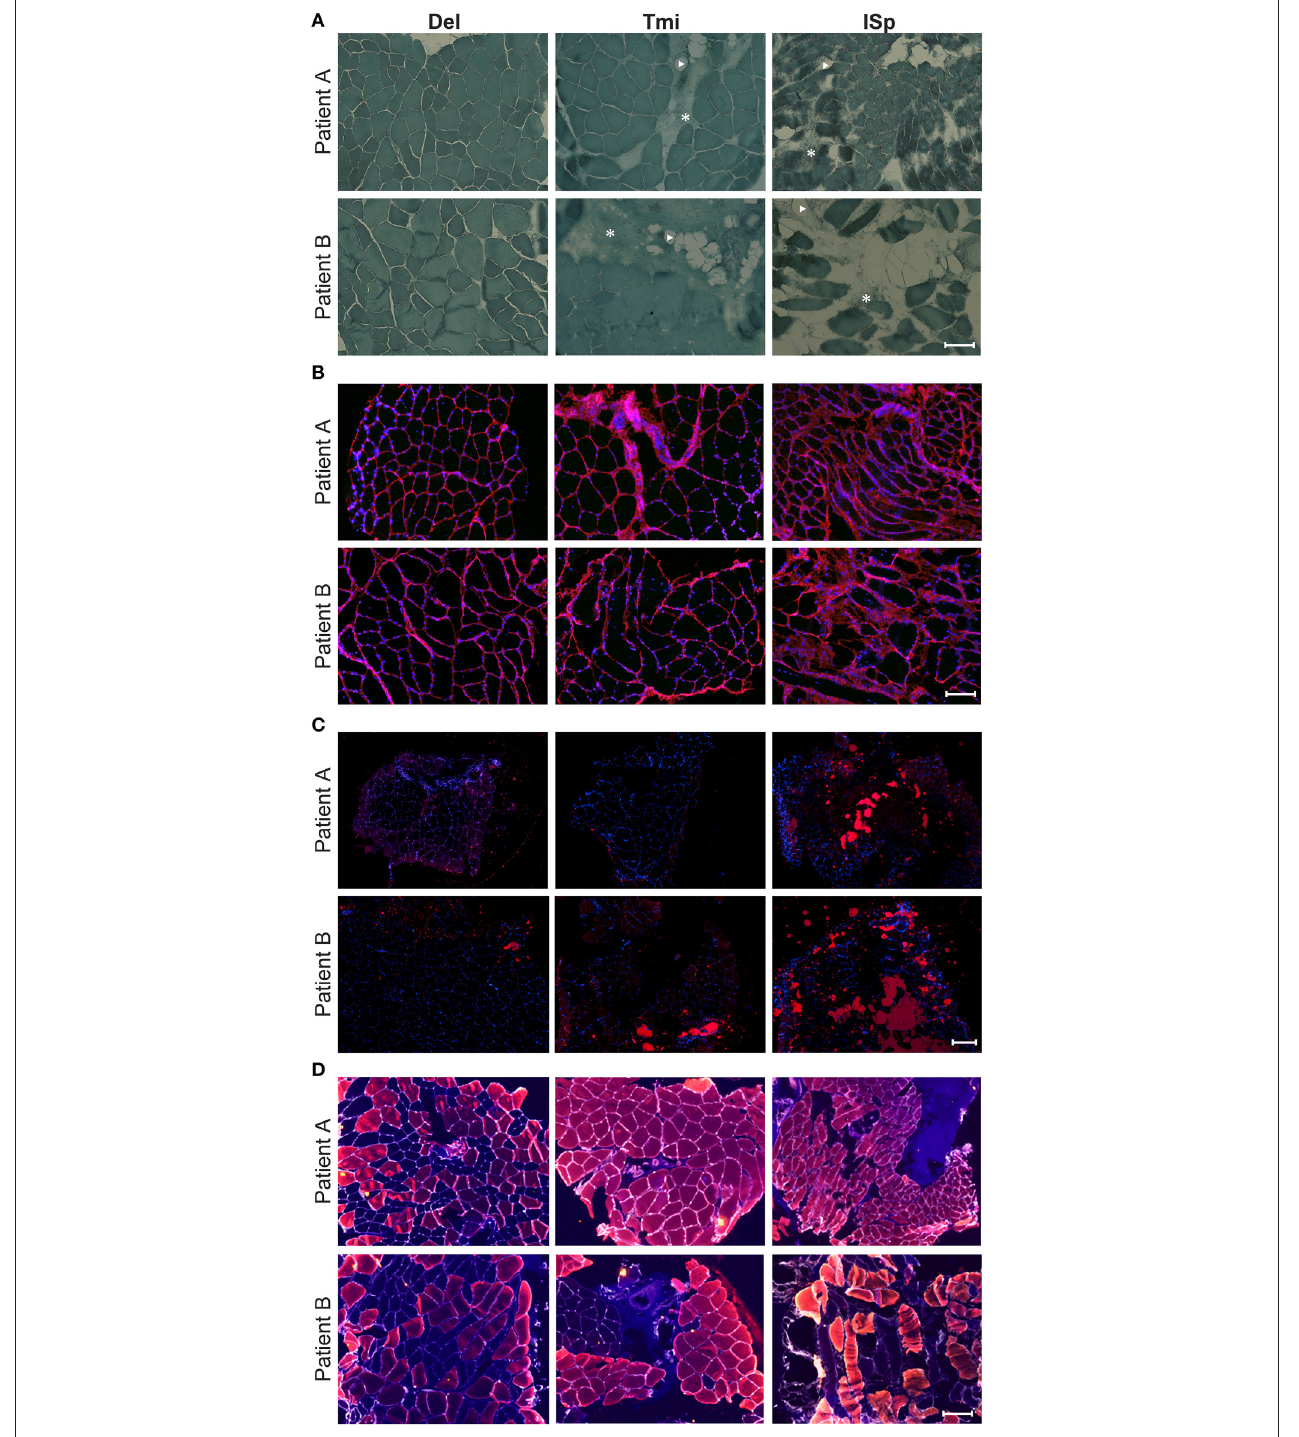
FIGURE 3 | Histological markers of muscle degeneration in torn and non-torn shoulder muscles. Representative images of histological analyses of biopsies of torn infraspinatus (ISp), non-torn RC muscle teres minor (Tmi), and deltoid (Del) in two patients. (A) Gomori-Trichrome staining shows myofibers in blue-green, nuclei in purple. Fat cells are negatively stained (arrow heads) and fibrotic areas are stained light blue-green (asterisks). Scale bar represents 100 µ m. (B) Collagen immunostaining (red), nuclei are counterstained with DAPI (blue). Scale bar represents 100 µ m. (C) Fatty droplet (red) staining, nuclei are counterstained with DAPI (blue). Scale bar represents 200 µ m. (D) Immunostaining for myosin heavy chain (MyHC) isotypes: MyHC-1 (blue), MyHC-2a (red), MyHC-2x (yellow), and the basal lamina (gray). Scale bar represents 100 µ m.